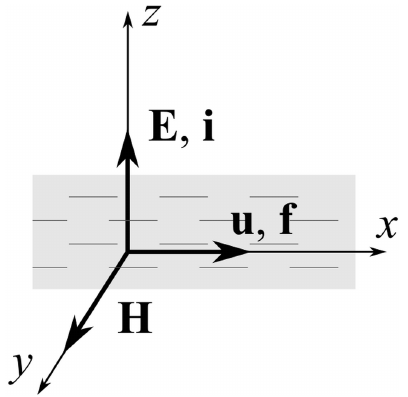
Figure 1. A plane one-dimensional flow for the chosen